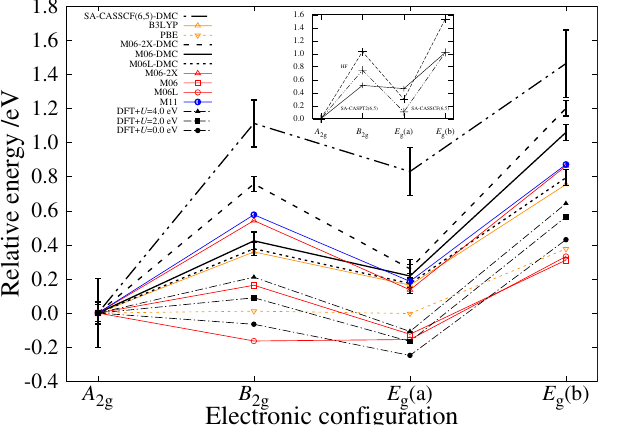
Figure 1. The predictions of some ab initio methods. This graph shows the predictions of CASSCF-DMC, DFT- DMC, HF, CASSCF, CASPT2, and some DFT calculations about the relative stability among the four electronic